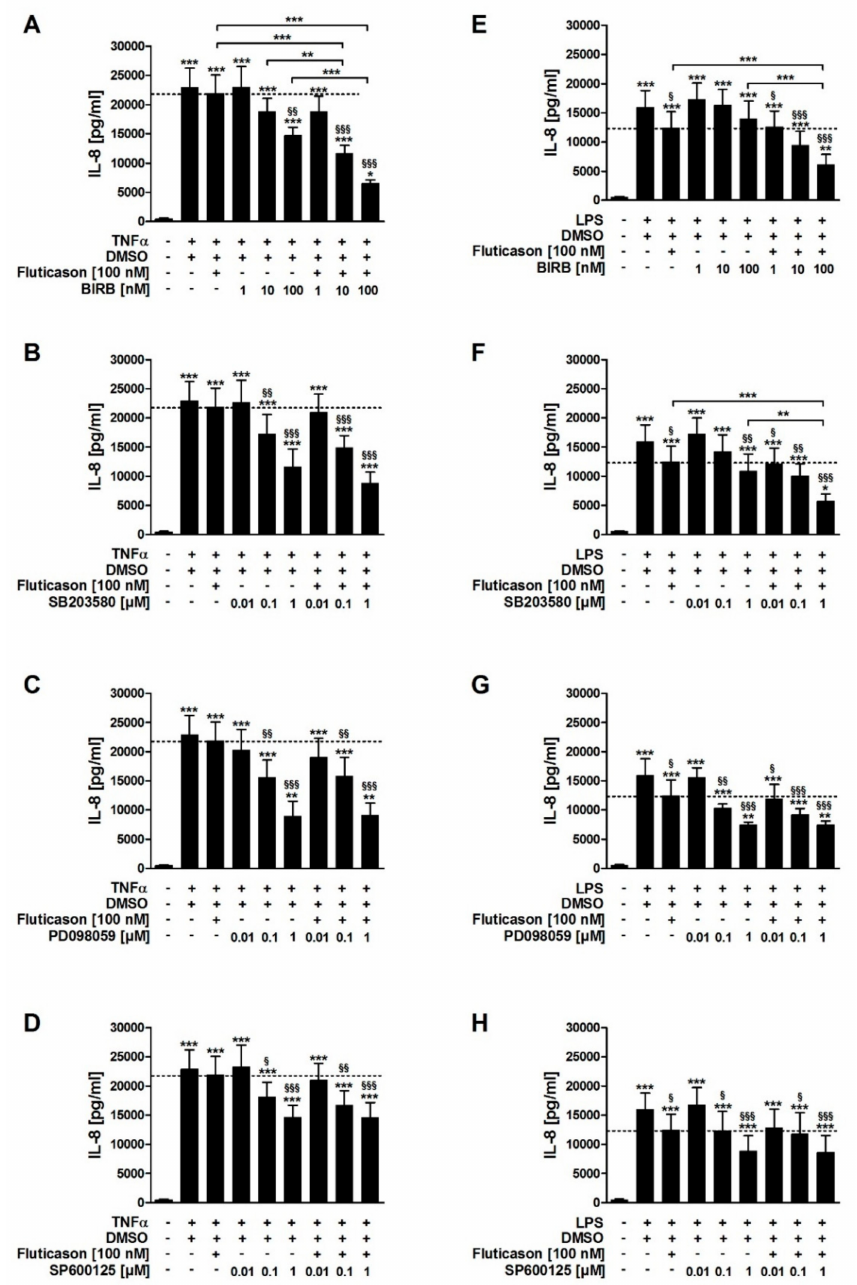
Figure2. E ff ectsofmitogen-activated-protein-kinase(MAPK)blockersonthecorticosteroidinsensitivity of IL-8 in HASMCs of COPD subjects. HASMCs ( n = 5) of COPD subjects were treated with fluticason propionate (100 nM; ( A – H )), BIRB796 (p38MAPK α , - γ , - δ inhibitor; (A,E)), SB203580 (p38MAPK α and - β inhibitor; (B,F)), PD098059 (inhibitor of ERK activation; (C,G)), SP600125 (JNK inhibitor; (D,H)) or with DMSO (0.45%, solvent control) two hours prior to stimulation with TNF α (20 ng / mL; (A–D)) or LPS (1 µ g / mL; (E–H)). After 72 h of incubation, IL-8 was measured in culture supernatants by ELISA. Data are presented as mean ± SEM. One-way repeated-measures ANOVA with 95% CI: (A–H), p < 0.0001; post-hoc Bonferroni analyses: * p < 0.05; ** p < 0.01; *** p < 0.001 vs. unstimulated control or as indicated; § p < 0.05; §§ p < 0.01; §§§ p < 0.001 vs. TNF α + DMSO (A–D) or LPS + DMSO